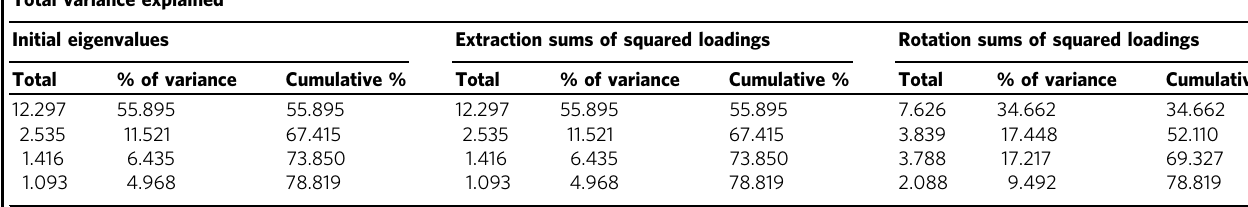
Table 3 The component and total variance explained of input QA for teaching and learning constructs. Total variance explained Initial